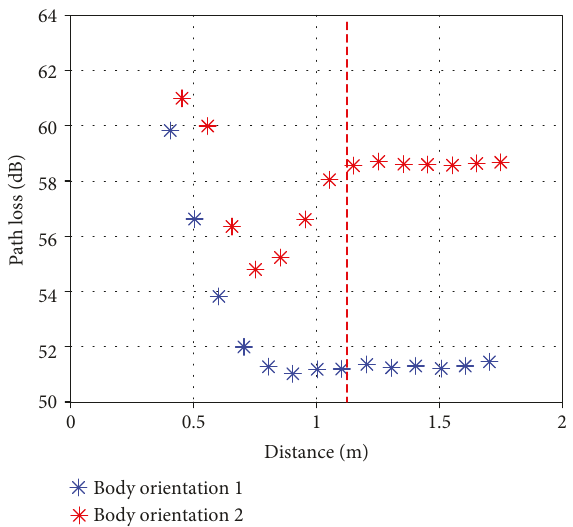
Figure 9: Path loss obtained using FDTD for a dipole receiving antenna at various distances from the